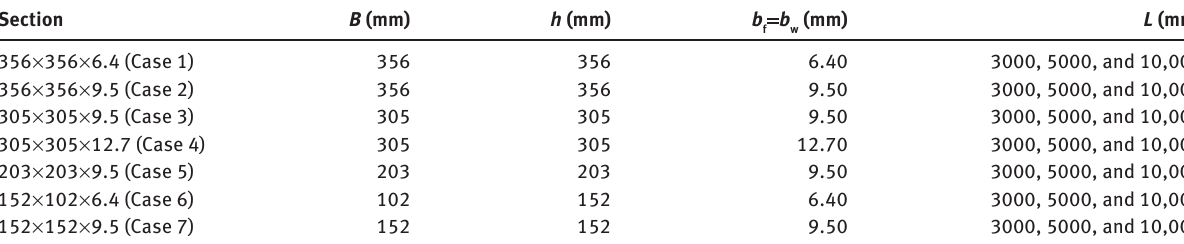
Table 1 Geometrical dimensions of unstiffened cruciform- and I-shaped section beams.